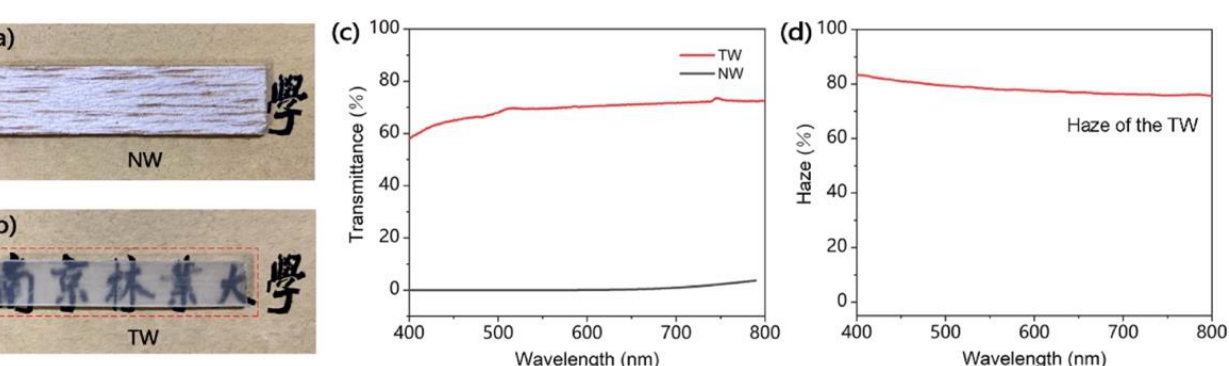
Figure 22. Comparison of optical properties between natural (pristine) wood (NW) and transparent wood (TW). ( a , b ) Digital images of the NW and TW laid on the same pattern. ( c ) Optical transmittance of the NW and TW. ( d ) Optical haze of the TW. Reprinted permission from [41], under CC-BY